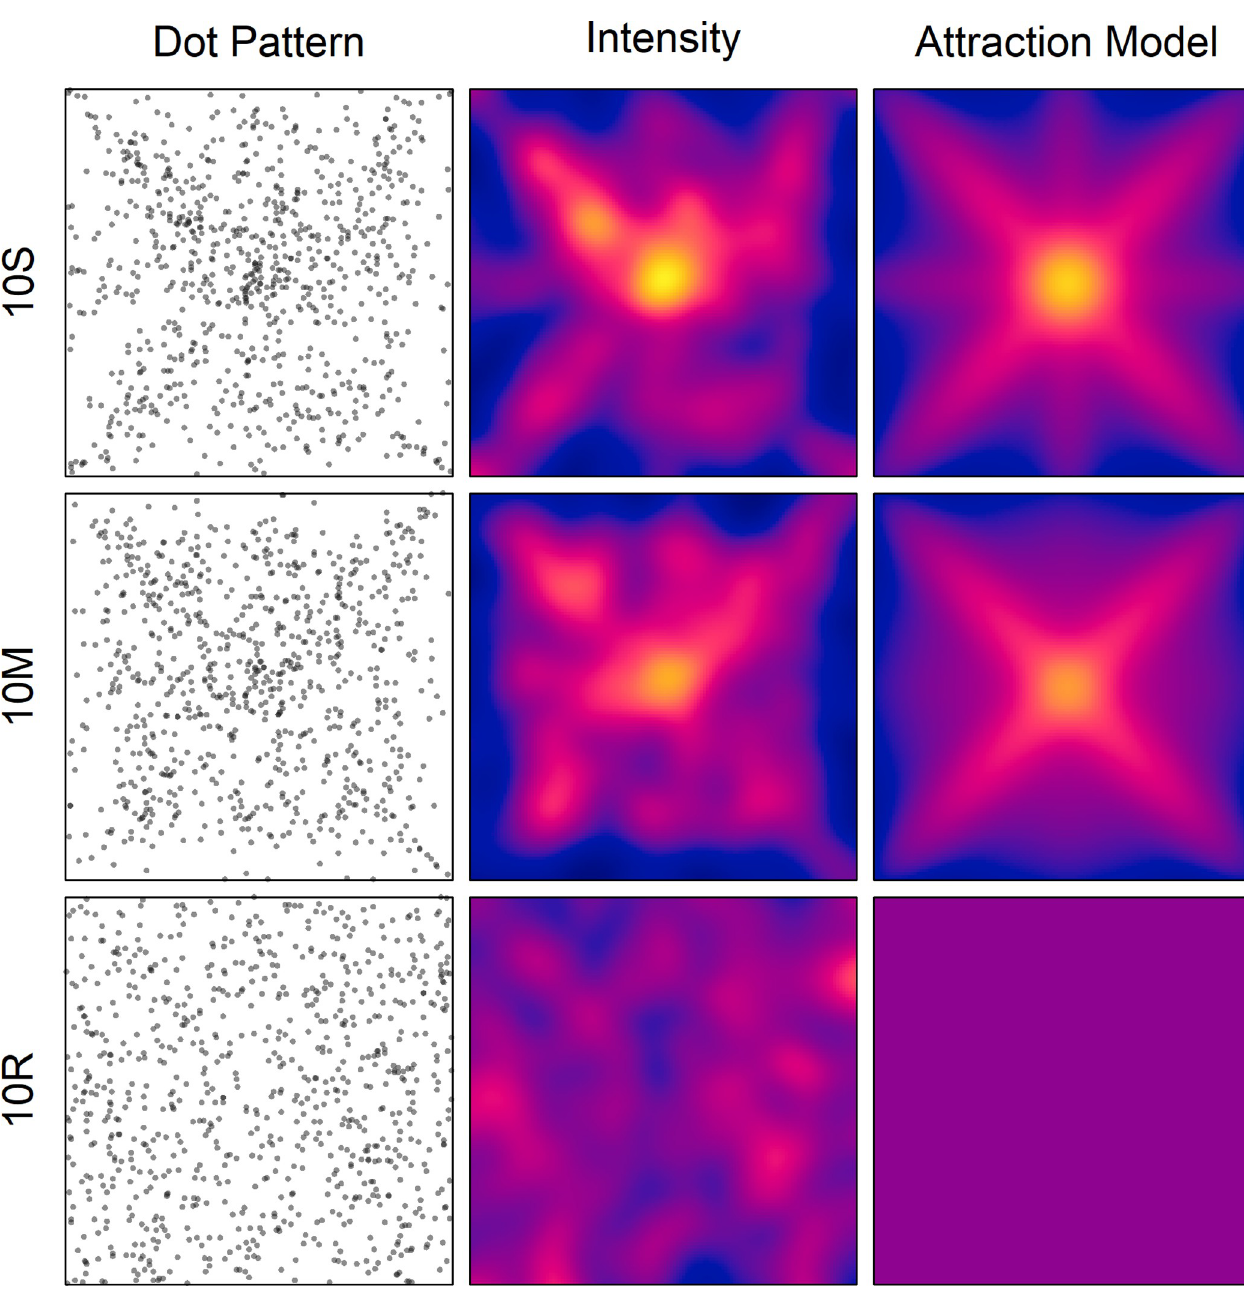
Fig 1. Superimposed dot patterns (column Dot Pattern) for the two conditions in Experiment 1, and for a random-dot pattern with the same number of dots (10R). The maps of the corresponding estimated intensities (column Intensity) are also shown. The intensity in the maps ranges from 0.0002 (blue) to 0.0122 (yellow). The right column depicts the maps of the modelled spatial attractions (see text for